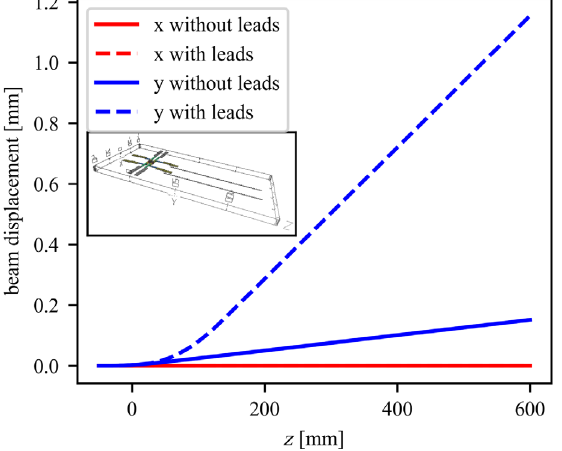
FIG. 10. RADIA simulations without (solid lines) and with (dashed lines) extra 100-mm long leads on the back of the device, showing the effects on the overall beam displacement in both x and y